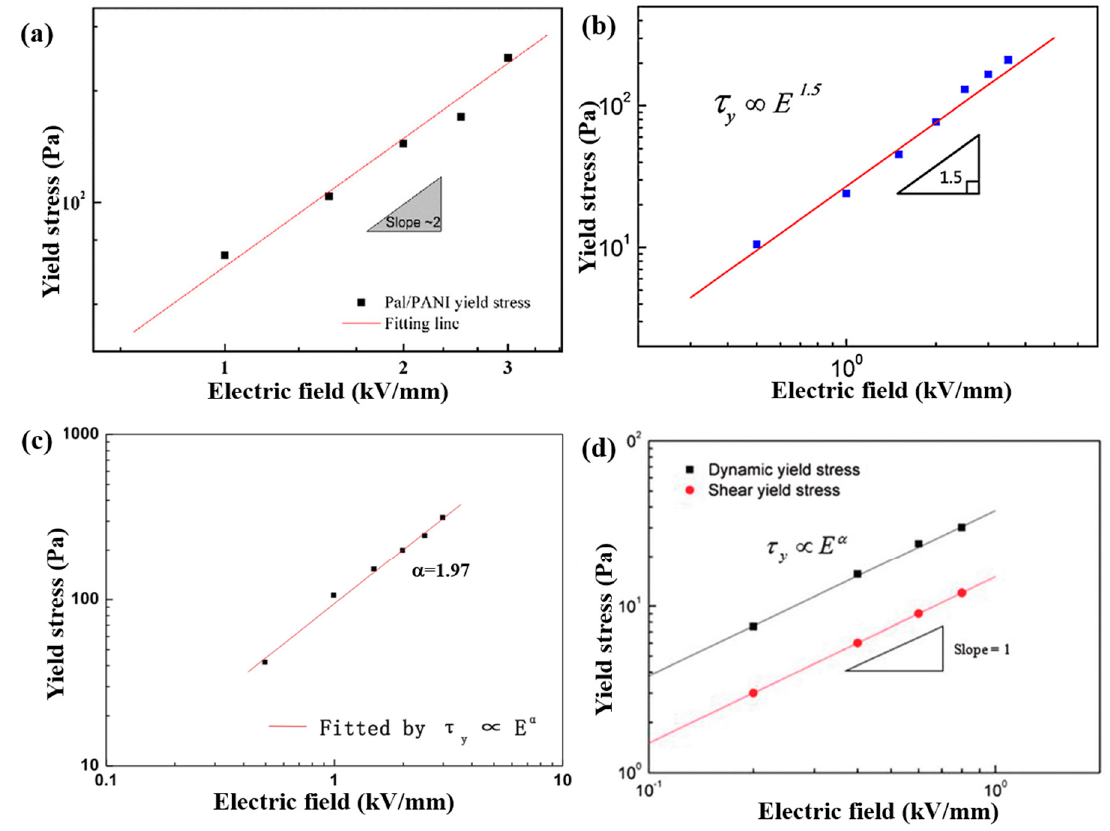
Figure 11. Dynamic yield stress as a function of electric field strength for ER fluids based on ( a ) Pal / PANI (10 vol %) (Chae et al. [76], © Elsevier, 2015), ( b ) PMMA-PNMA (10 vol %) (Moon et al. [77], © Elsevier, 2015), ( c ) flower-like Fe 2 O 3 / PANI (20 wt %) (Tian et al. [73], © Elsevier, 2016) and ( d ) Fe 3 O 4 / PPy (10 vol %) (Park et al. [97], © The Royal Society of Chemistry, 2015).